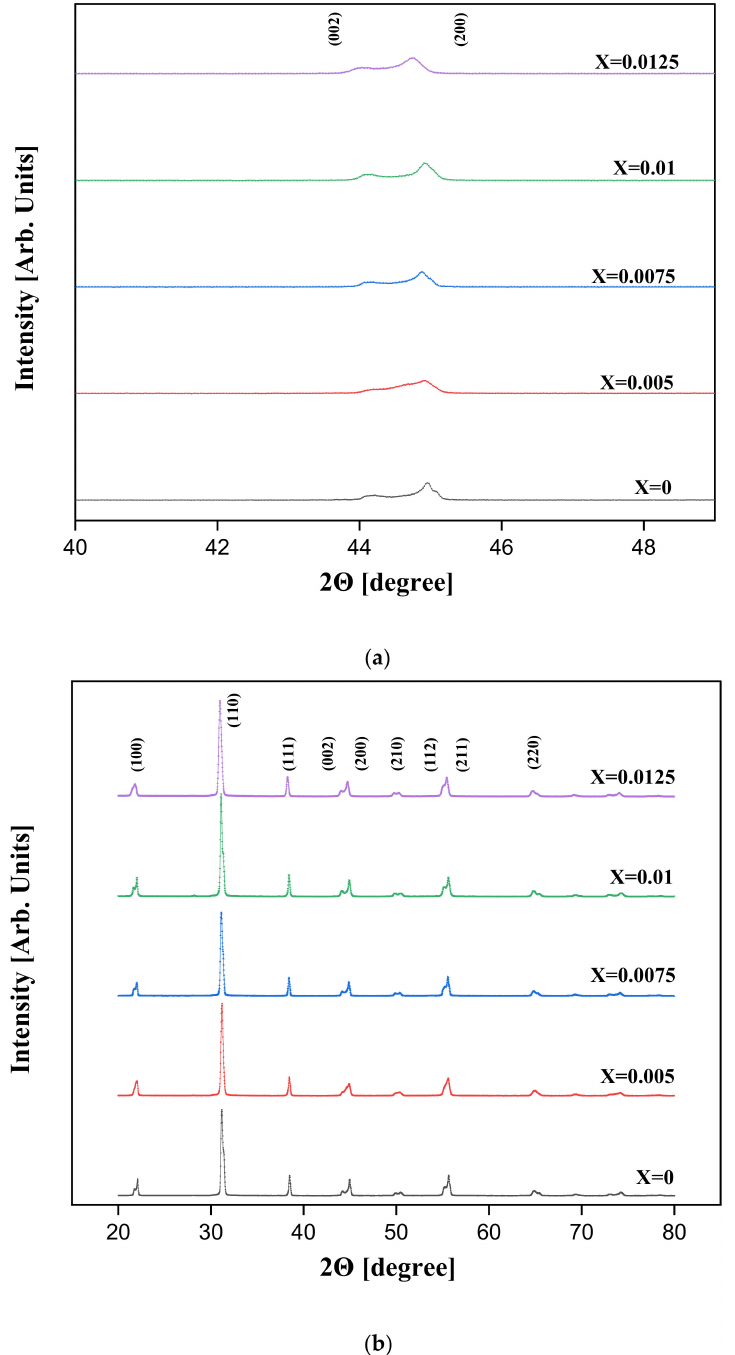
Figure 1. XRD pattern with Sm substitution (( a ) narrow angle range ( b ) wide angle